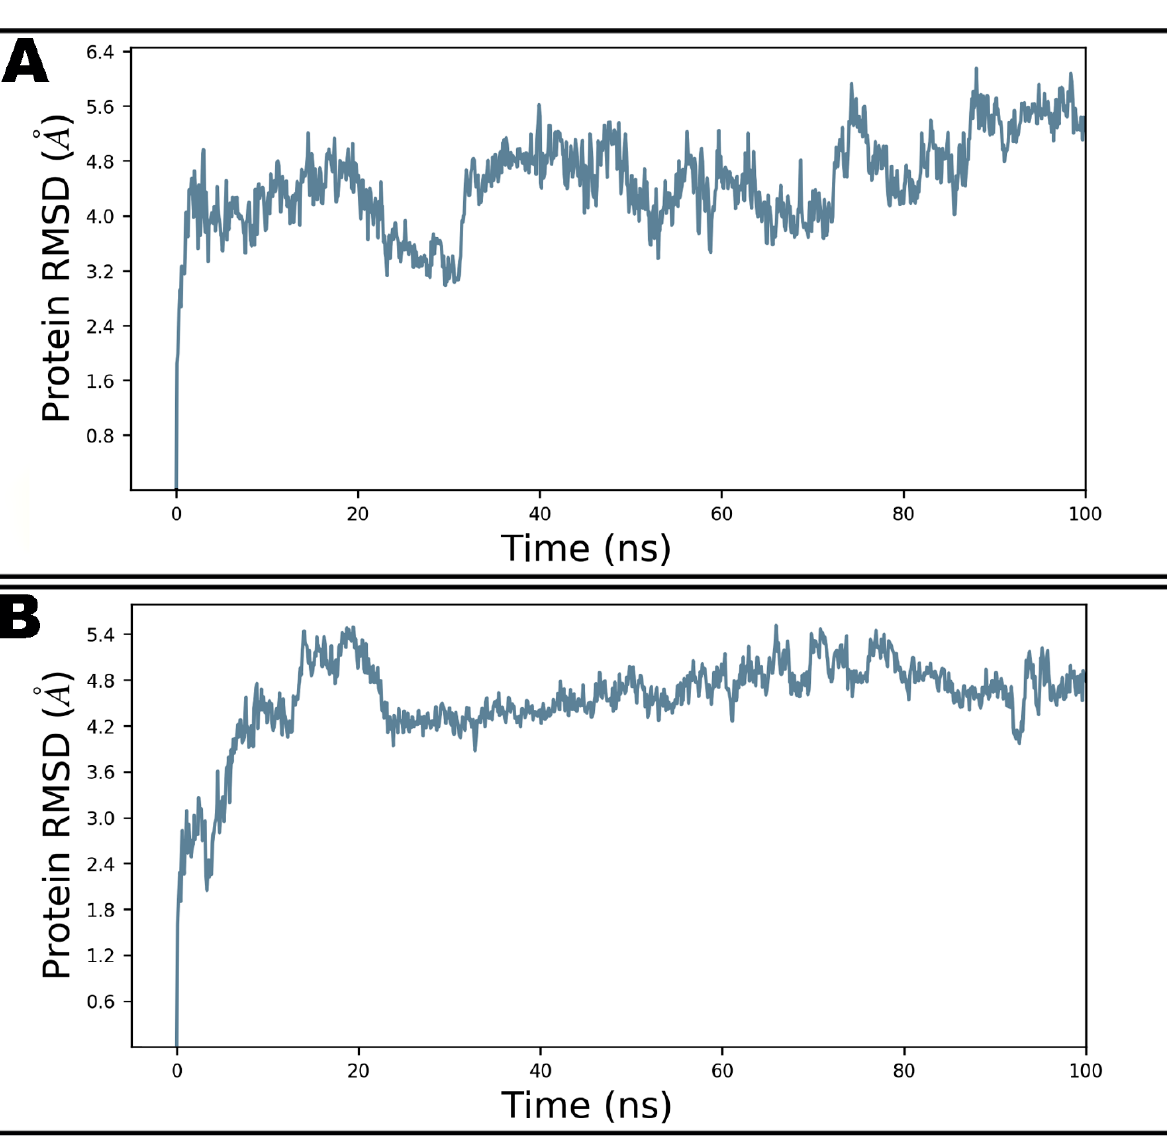
Figure 5. The root-mean-square deviations (RMSD) of C α atoms of N-protein–N-domain in unbound state ( A ) and teicoplanin-bound state ( B ) during 100 ns molecular dynamics simulation.